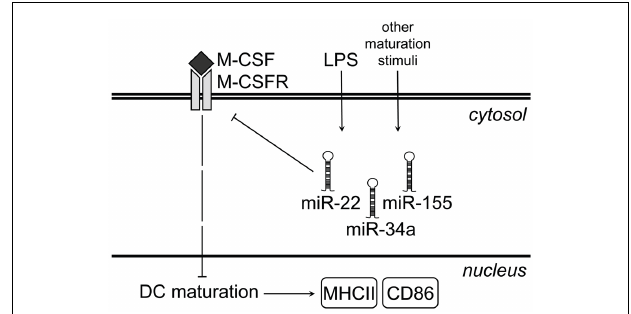
FIGURE 5 | Proposed model for microRNA-mediated regulation of M-CSFR upon LPS-induced GM-DC maturation . Under steady-state conditions, immature GM-DC express high levels of M-CSFR. As a result of M-CSFR signaling, expression of maturation markers such as MHC class II and CD86 remains low. LPS stimulation of iDC or other maturation-inducing stimuli up-regulate miR-22, -34a, and -155, which bind to Csf1r mRNA and prevent translation of M-CSFR protein.This results in down-regulation of M-CSFR protein at the cell surface and allows up-regulation of both MHC class II and